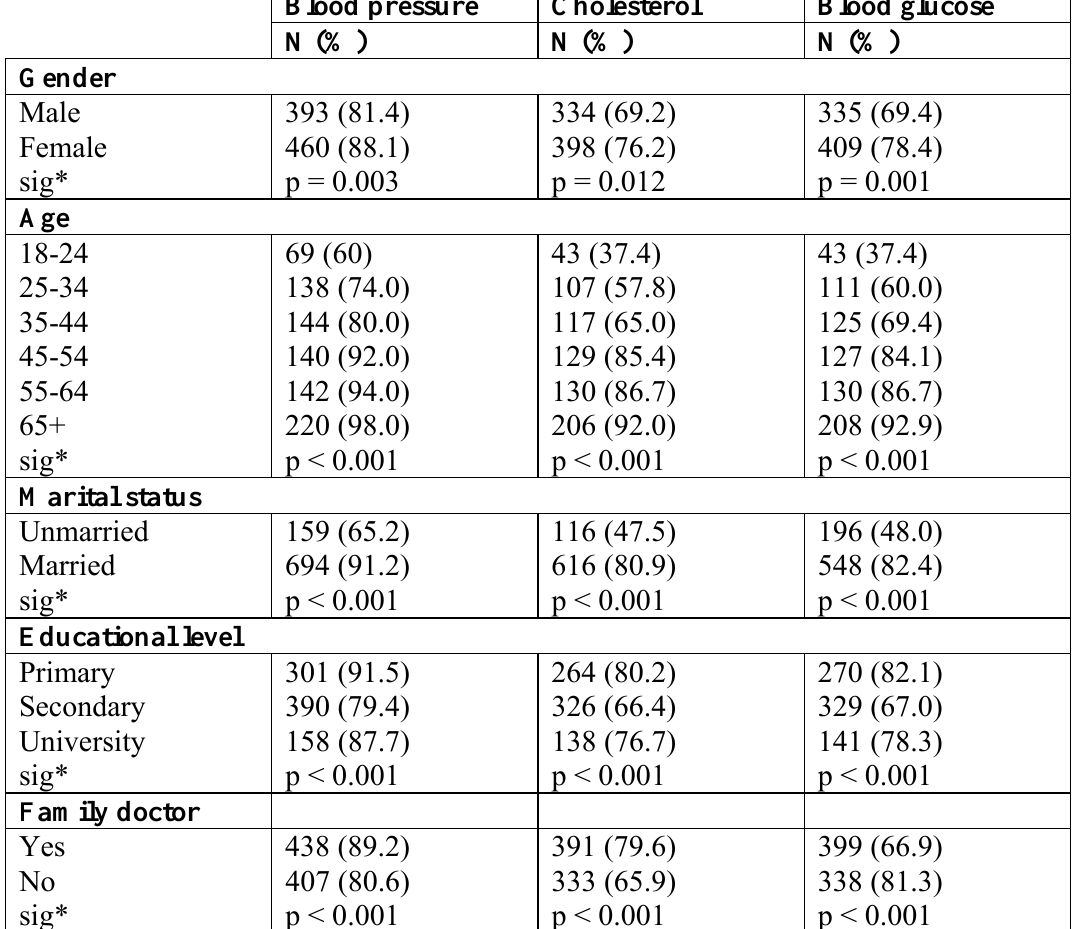
Table 3. Use of preventive tests according to socio-demographic